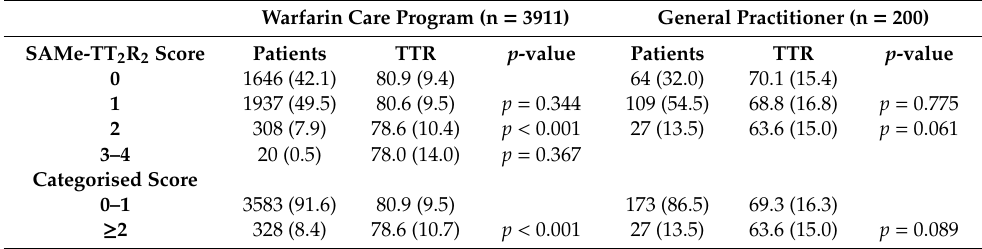
Table 2. Time in therapeutic range (TTR) in relation to SAMe-TT 2 R 2 (Sex, Age, Medical history, Treatment, Tobacco use, Race - Caucasian) score for patients managed by a warfarin care program and by a general practitioner. Data is represented as number (percentage) for patients and mean (standard deviation) for time in therapeutic range with statistics shown for comparison to SAMe-TT 2 R 2 score 0 or 0–1 when